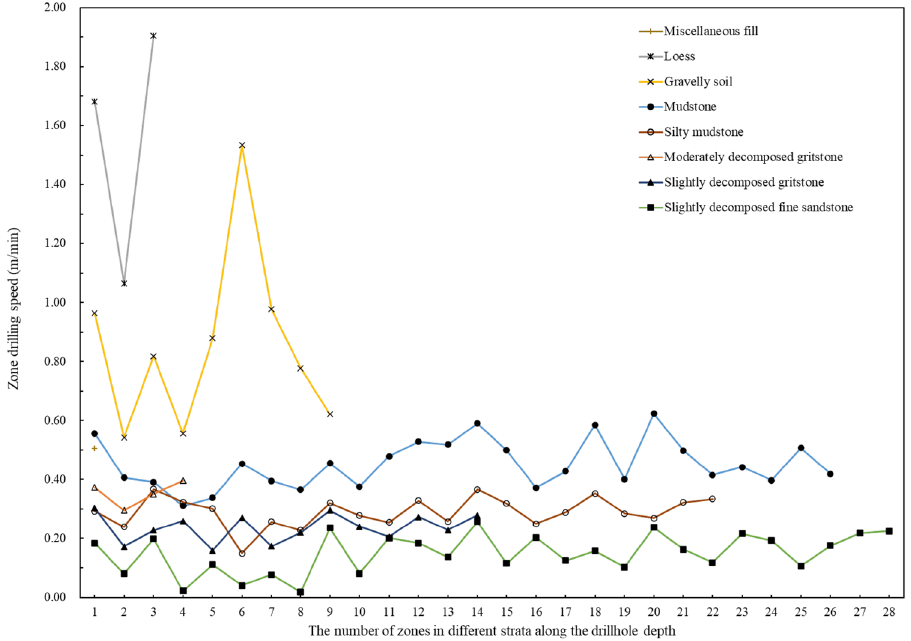
Figure 6. The number of constant mechanical zones in different strata with associated zone drilling speed.